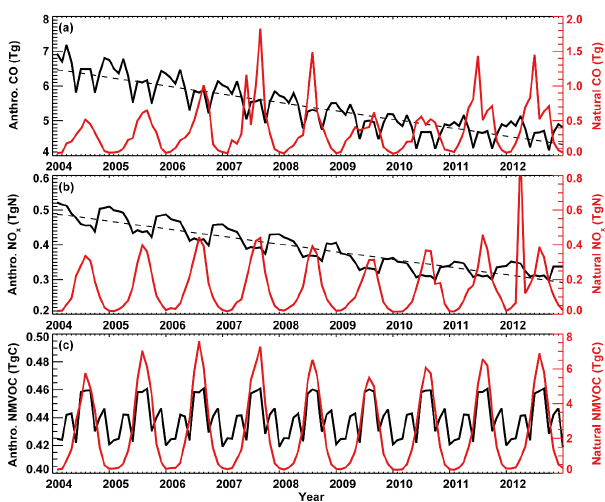
Figure 2. Monthly anthropogenic (fossil + biofuel, black lines) and natural (red lines) emissions of ozone precursors over the US used in GEOS-Chem. Natural NO x emissions include biomass burning, lightning, and soil (including fertilizer) sources. Natural CO emis- sions are from biomass burning and oxidization of monoterpenes. Natural NMVOC emissions are from biomass burning and biogenic sources.